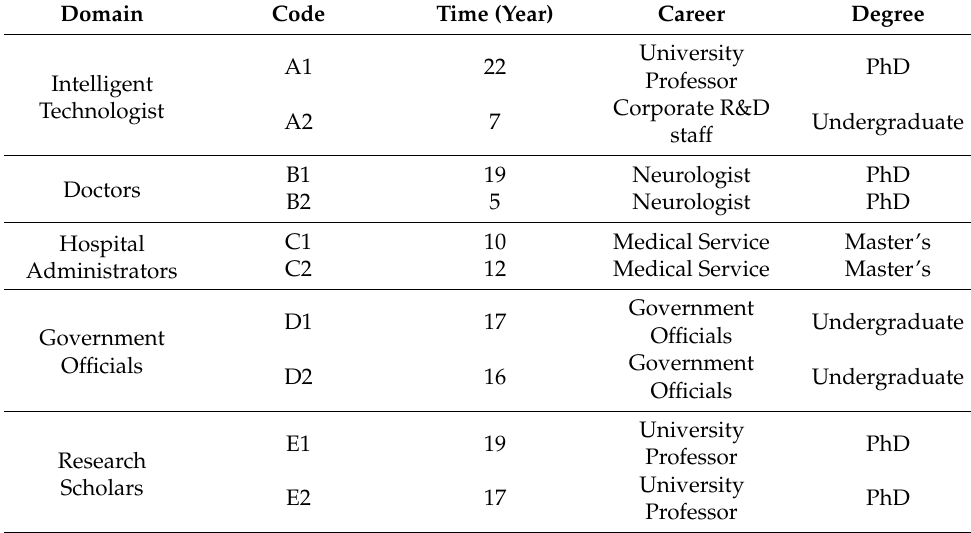
Table 2. Demographics of the participants.